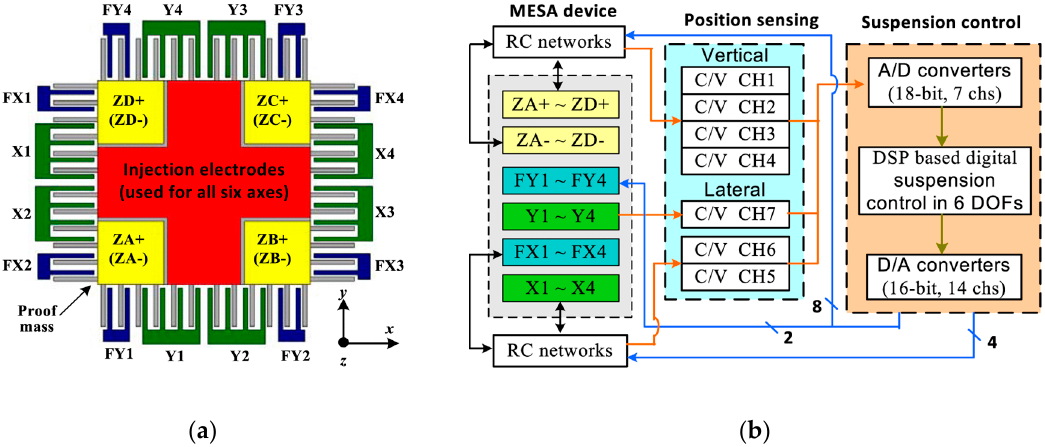
Figure 22. Schematic diagrams of MEMS electrostatically levitated accelerometer electrodes and suspension control loop developed by Han et al. at Tsinghua University [125]: ( a ) top view of device electrode; ( b ) digital suspension control loop.